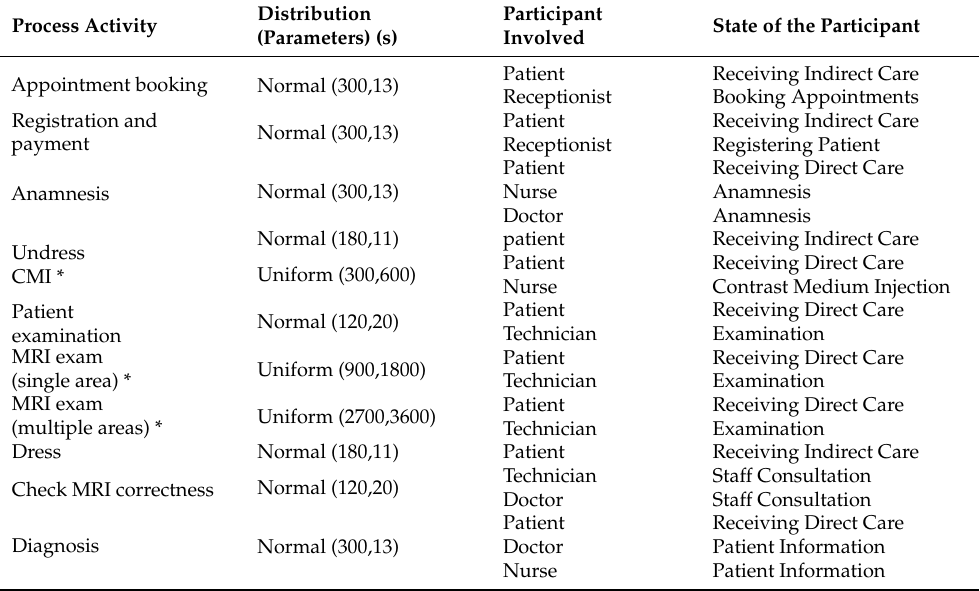
Table 2. Time distribution of the key process activities—Baseline Model.